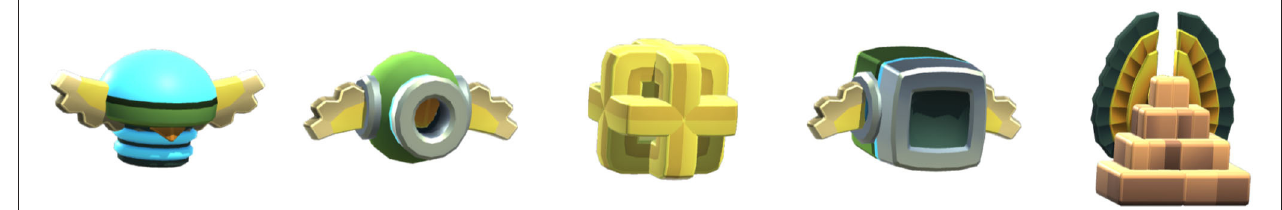
FIGURE 4 | The avatars which players can choose to represent ArtBot. In this paper they are referred to as A1 to A5 in sequential order from left to